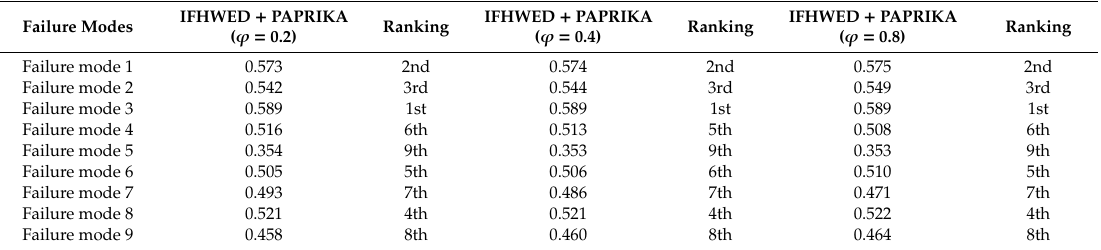
Table 13. Sensitivity analysis using IFHWED and subjective weightings of risk factors using PAPRIKA. Failure